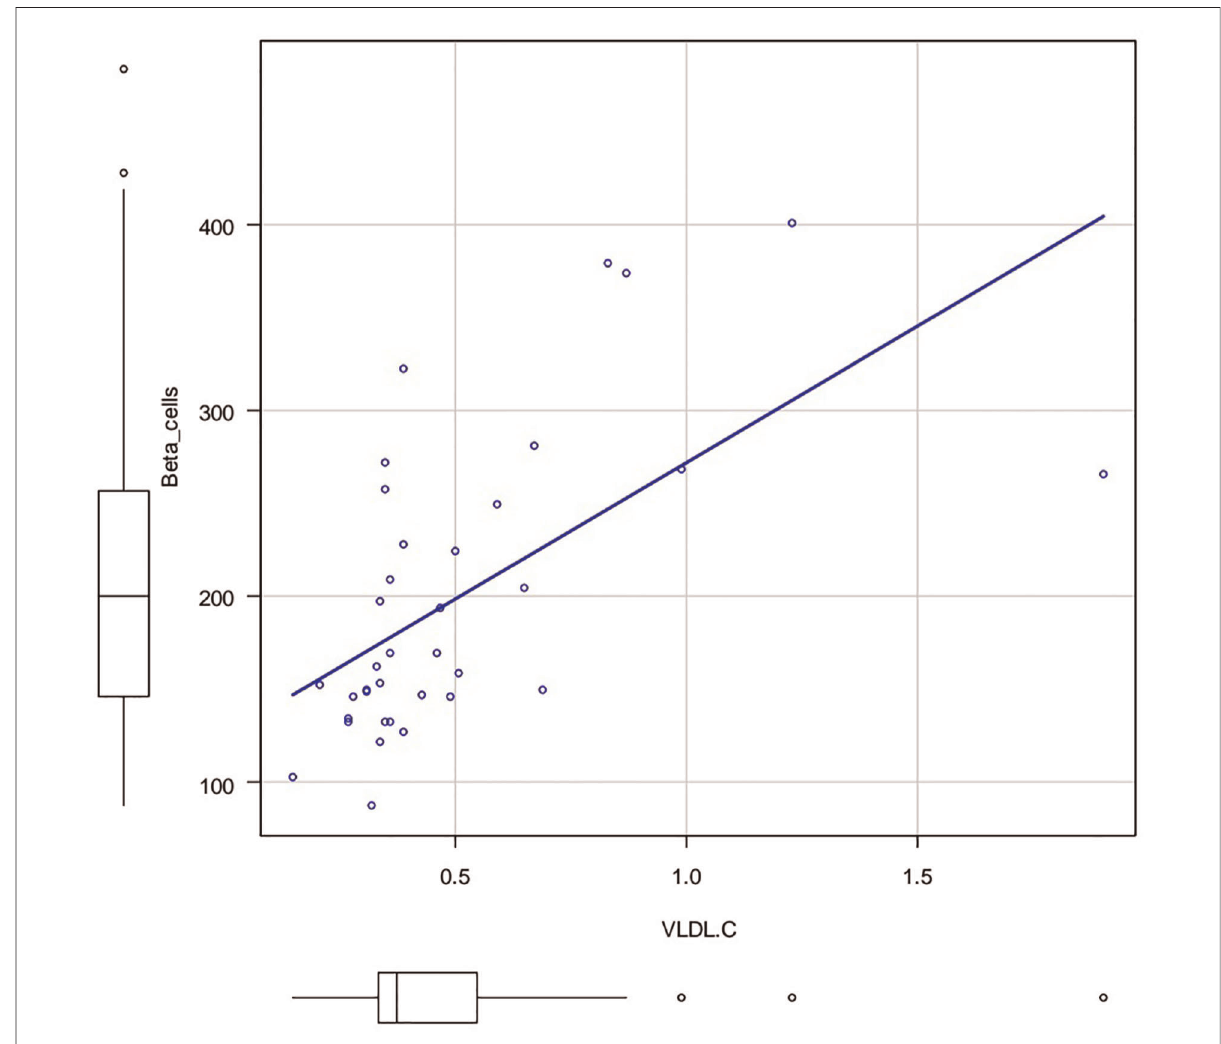
FIGURE 4 Correlation fi eld in coordinates: VLDL-C (X axis) and %B (Y axis). Spearman ’ s rank correlation coef fi cient 0.641 p